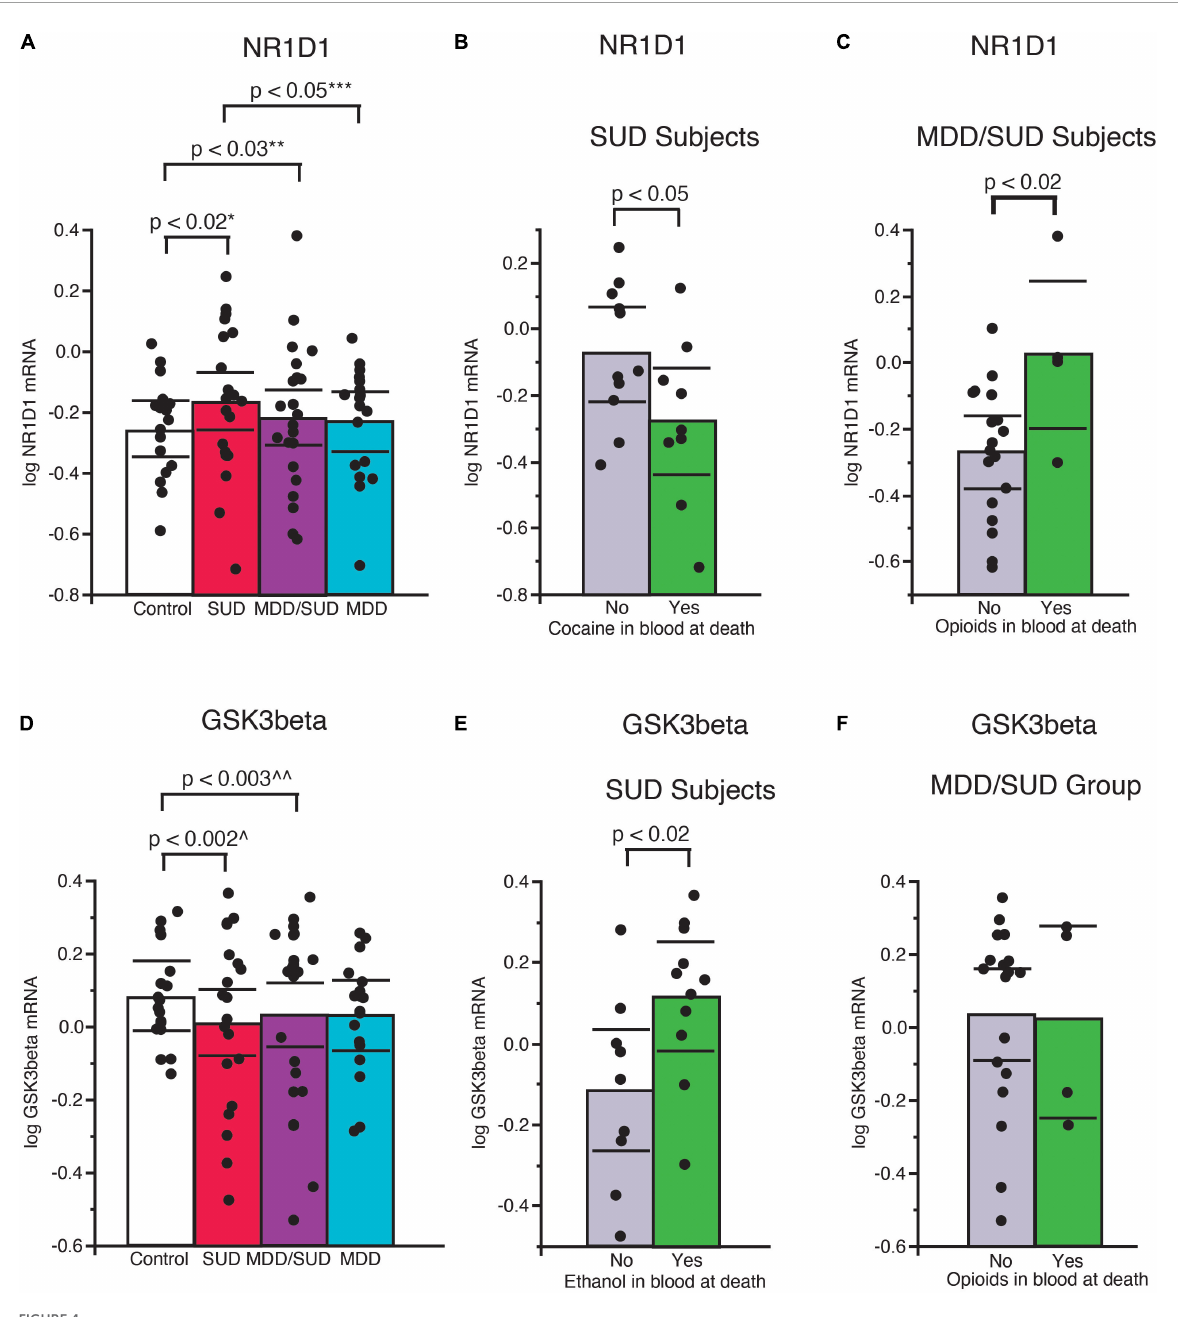
FIGURE4 Altered expression of NR1D1 and GSK3 β in the hippocampus of subjects with SUD. (A) Significantly greater Nr1d1 mRNA expression was observed in subjects with SUD compared to control subjects ( p < 0.02, *adjusted for significant effect of cocaine in the blood at death). Subjects with SUD with cocaine in the blood at death had significantly less Nr1d1 mRNA expression (B) . Subjects with MDD/SUD had significantly lower Nr1d1 expression compared to control subjects ( p < 0.03; **adjusted for significant effects of ZT time, duration of MDD, sex, opioids in the blood at death, smoking, and cocaine in the blood at death). Subjects with MDD/SUD with opioids in the blood at death had significantly higher Nr1d1 expression than subjects (C) . Subjects with MDD only had no significant difference in Nr1d1 expression when compared to control subjects (A) . Subjects with MDD only had significantly lower expression compared to subjects with SUD ( p < 0.05, ***adjusted for significant effect of cocaine in the blood at death). Scatterplots depicting normalized mRNA expression for Gsk3 β (D) . Gsk3 β mRNA expression was significantly decreased in subjects with SUD ( p < 0.002; ˆadjusted for significant effects of ZT time, interaction of ZT time and diagnosis, PMI, ethanol in the blood at death (E) , and opioids in the blood at death) (F) . Significance values are derived from stepwise linear regression models. Scatterplots show the mean (histogram) and 95% confidence intervals (black lines). ˆˆAdjusted for effects of duration of alcohol use disorder and